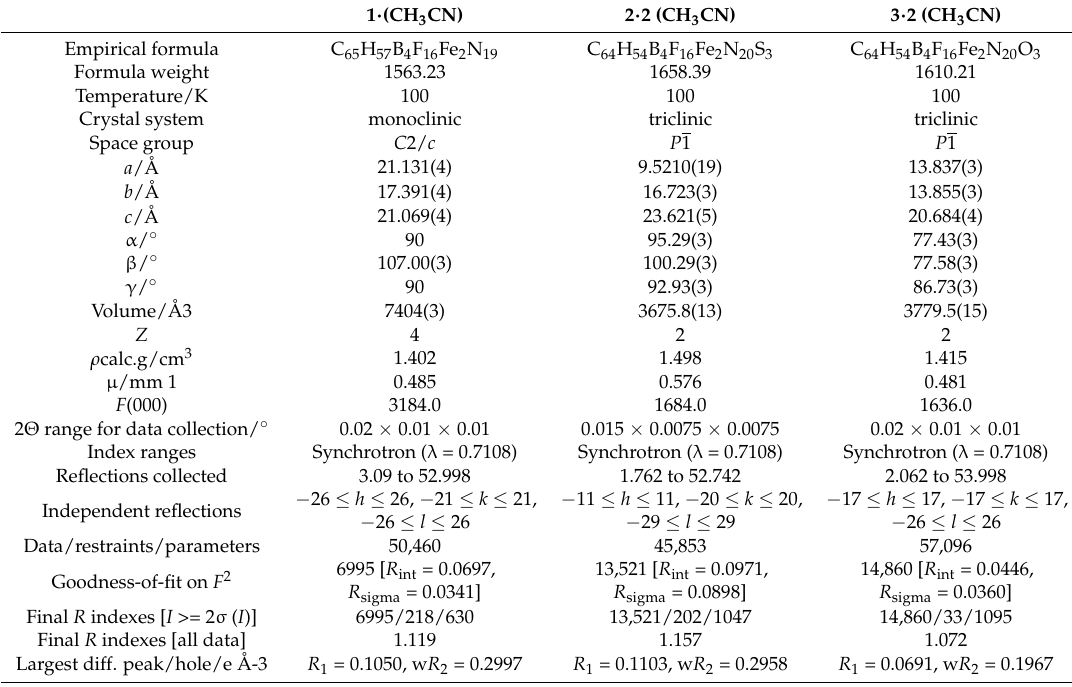
Table 3. Crystallographic data for the compounds measured in this